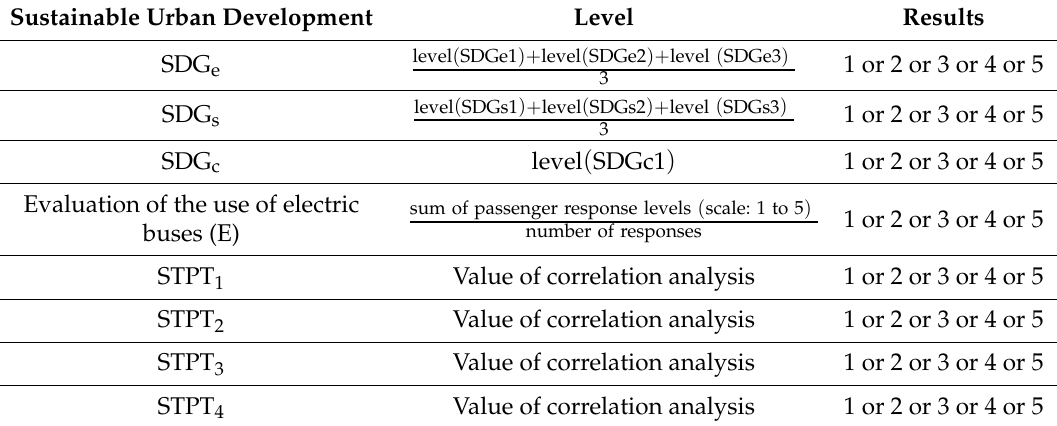
Table 1. Sustainable urban development